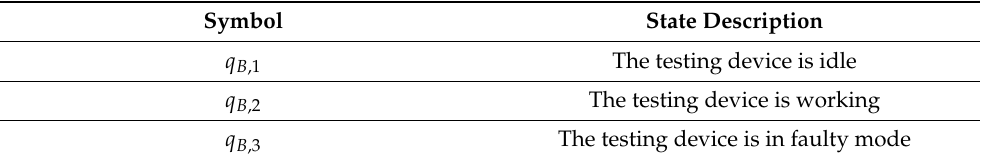
Table 7. States of the testing device.